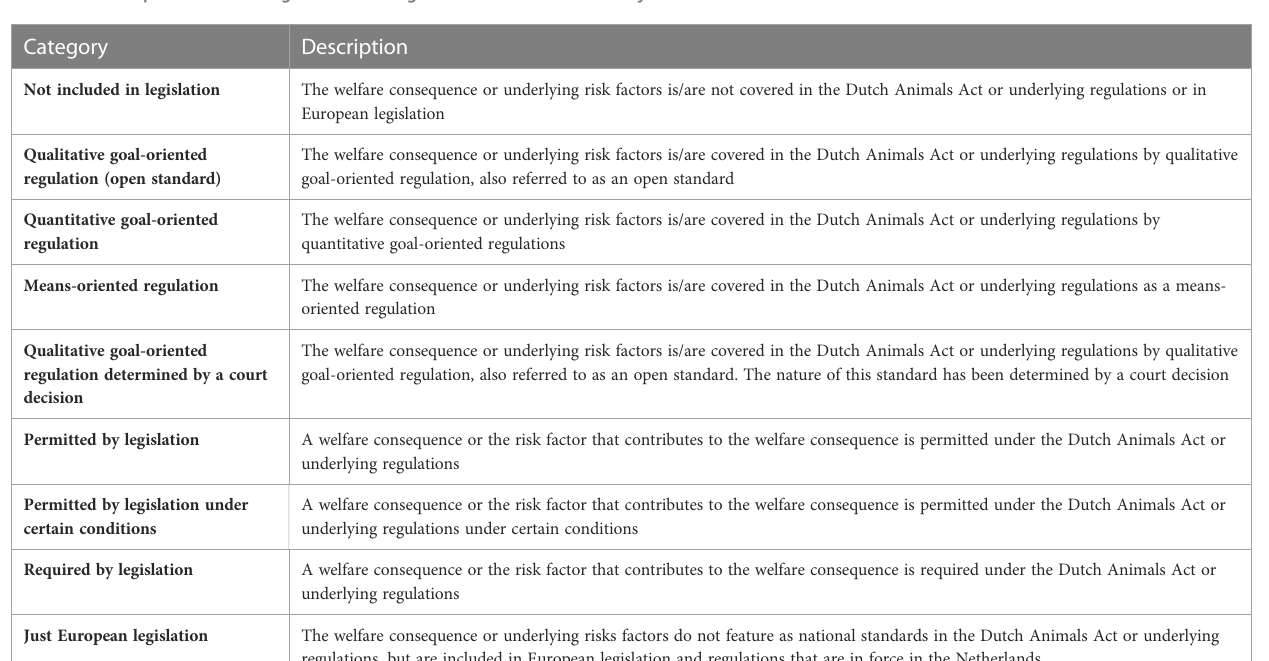
TABLE 2 Description of the categorization of legislation de fi ned in this